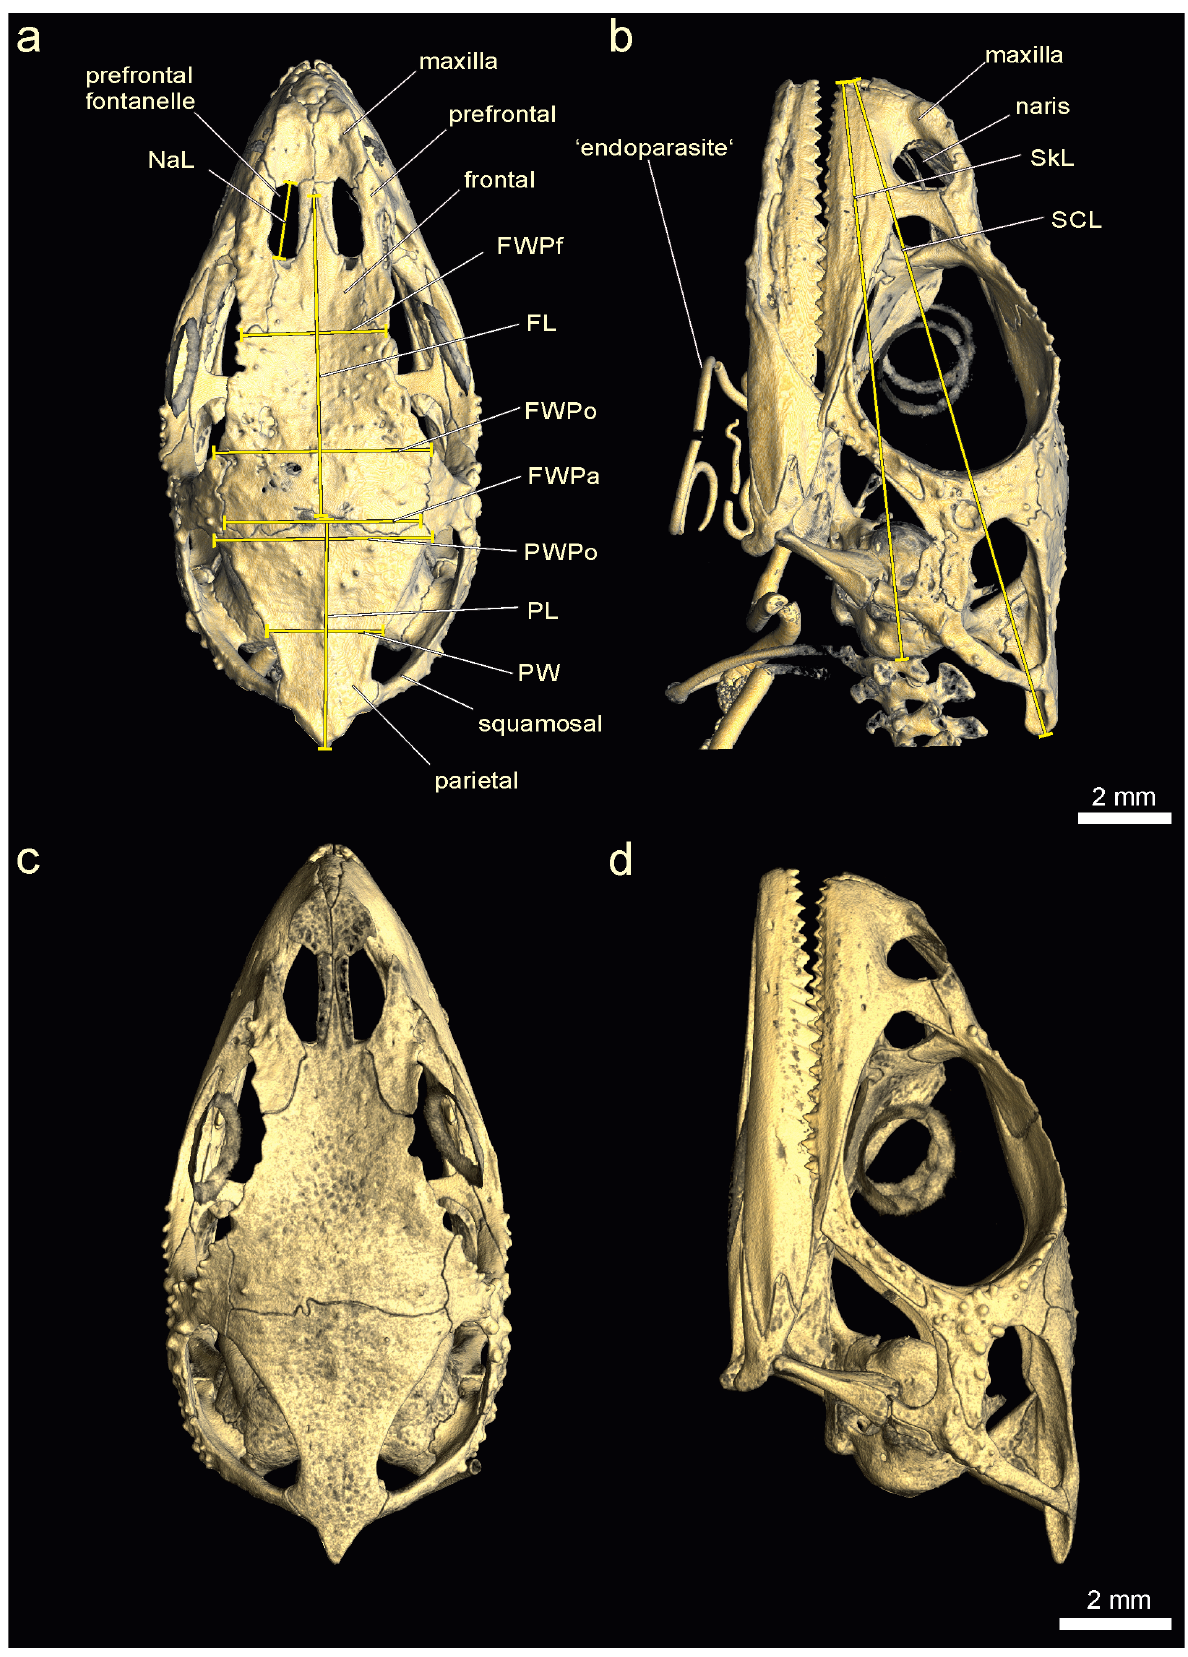
Figure 1. Micro-CT scans of skulls of Calumma roaloko sp. n. Male holotype KU 343178 in dorsal view ( a ) and lateral view ( b ), note the worm-like structure (presumably an endoparasite) in the throat of the holotype; female KU 343168 in dorsal view ( c ) and lateral view ( d ). See Materials and methods for abbreviations. See also Suppl. material 3 and 4 for a 360° movie of the